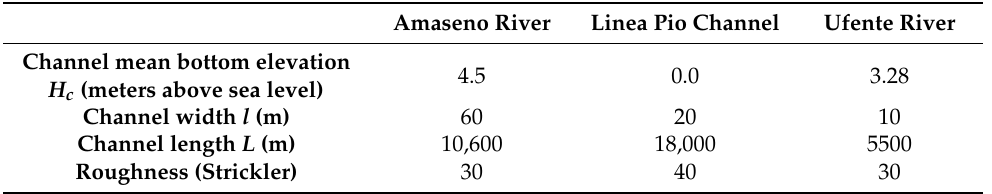
Table 4. Hydraulic parameters after the calibration of the model downstream from the Mazzocchio pumping system.